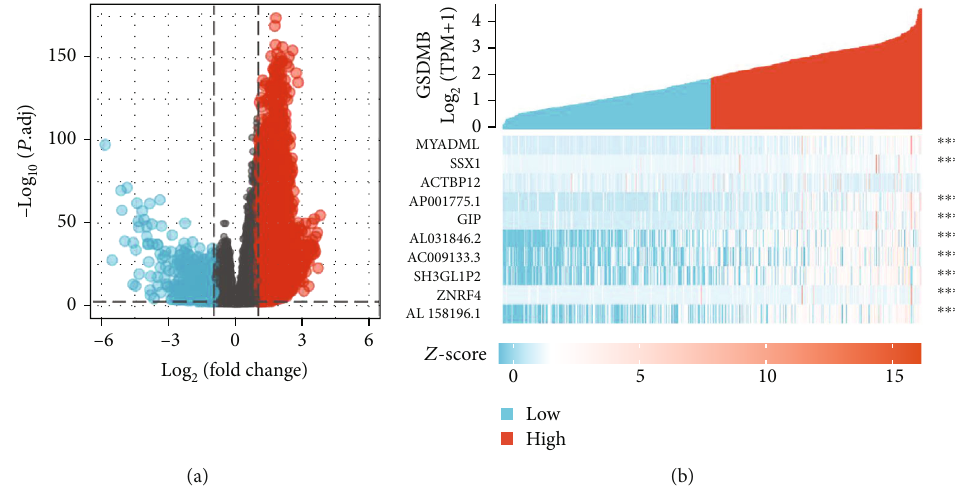
Figure 6: Di ff erentially expressed genes between patients with high and low GSDMB expression. (a) Volcano plot of di ff erentially expressed genes between the high and low GSDMB expression groups. Normalized expression levels are shown in descending order from green to red. (b) Heatmap of the top ten signi fi cant di ff erentially expressed genes between the high and low GSDMB expression groups. Green and red dots represent downregulated and upregulated genes,